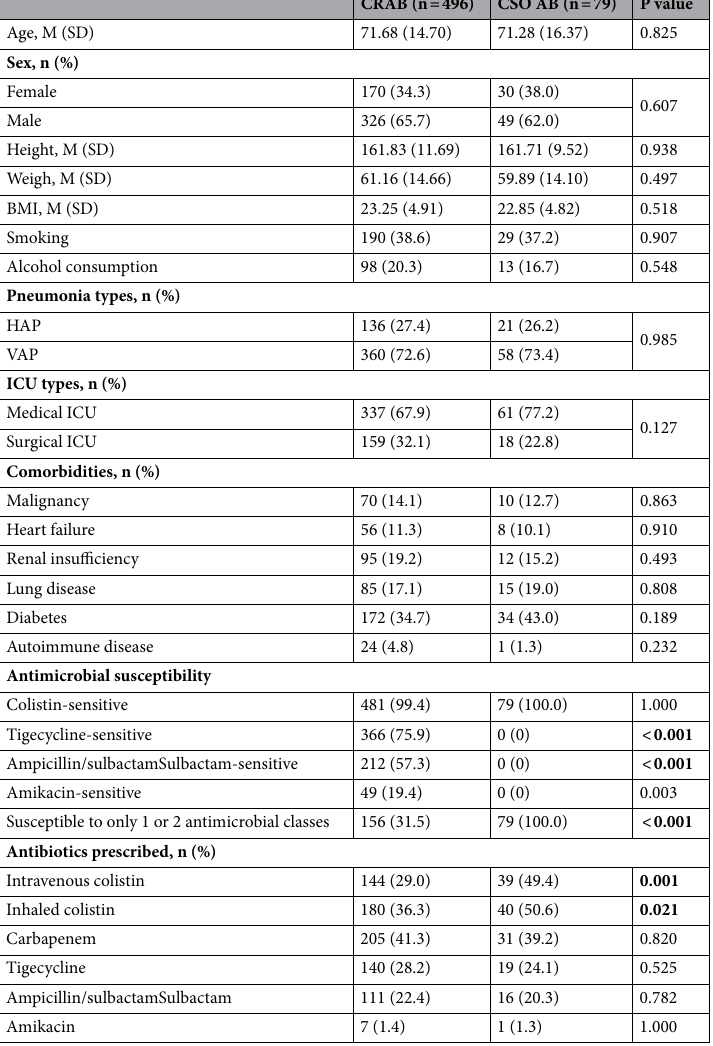
Table 1. Demographic characteristics of patients with CRAB and CSO AB pneumonia. M (SD) mean (standard deviation). Significant values are given in